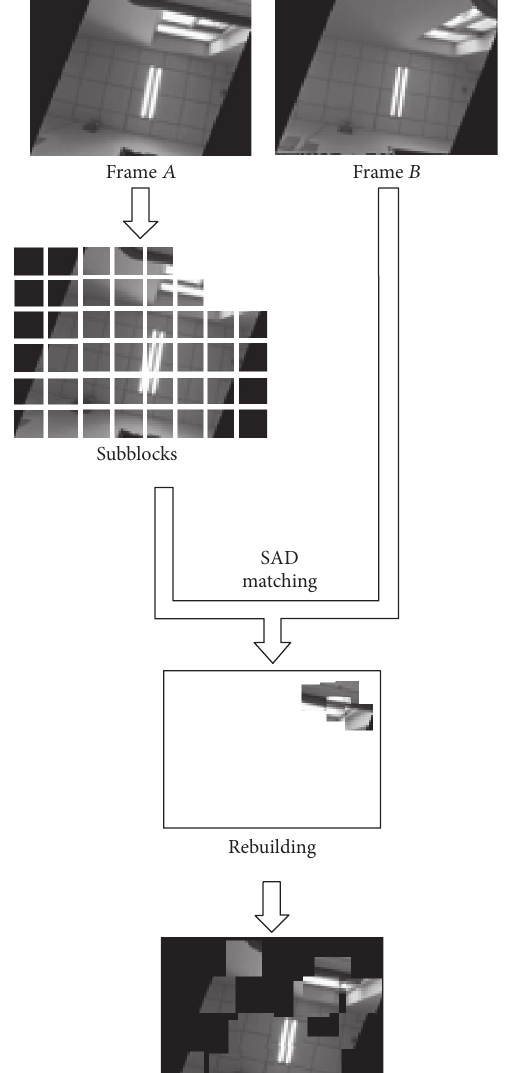
Figure 7: The overlap region rebuilding